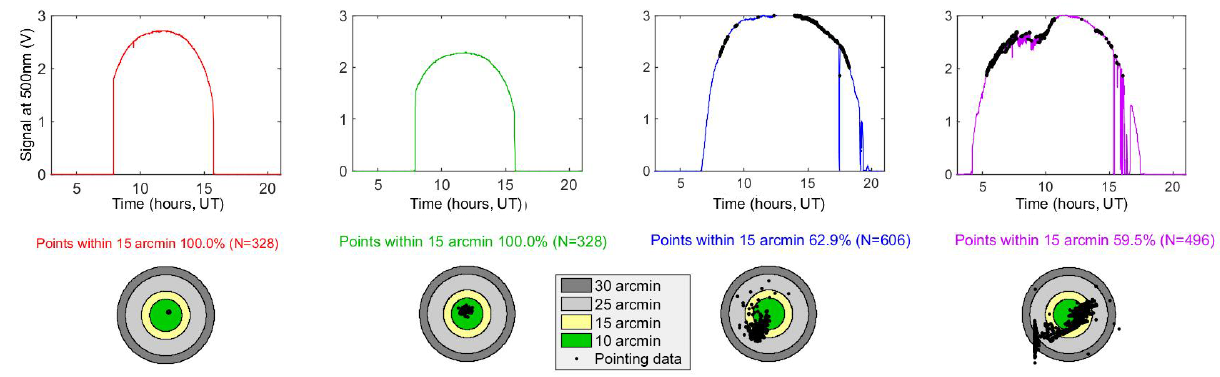
Figure 8. Example of good and bad pointing. (a) Instrument pointing, (b) instrument signal at 500nm. The two lower-right panels include some cloud-related signal changes after 15:00h